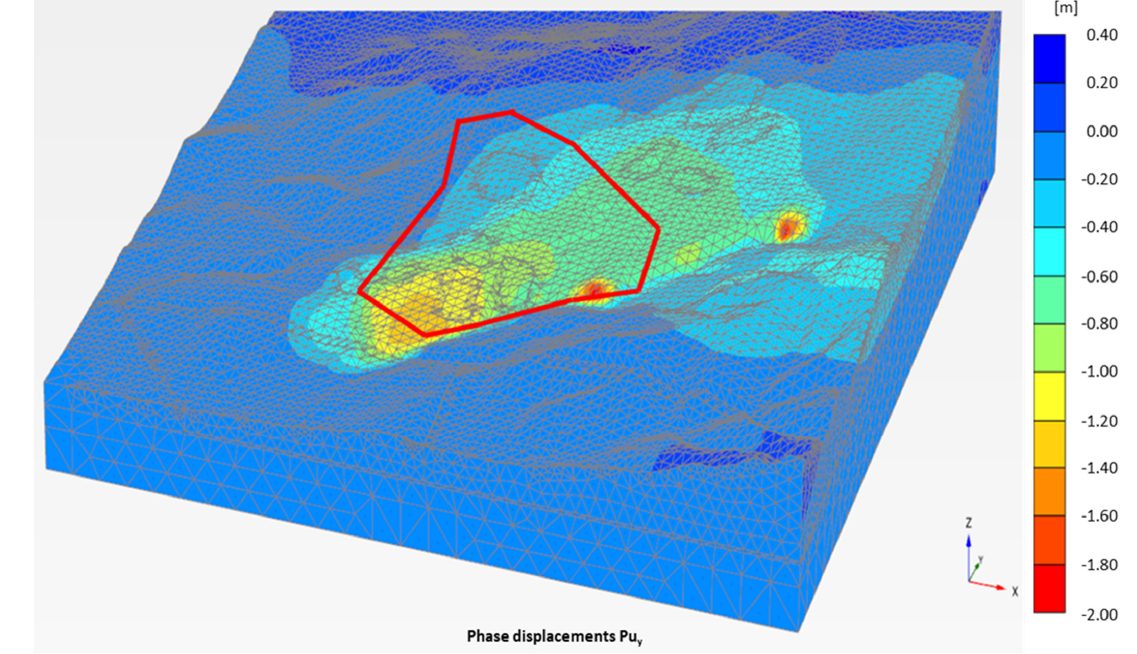
Figure 10. Y − direction displacement contours.